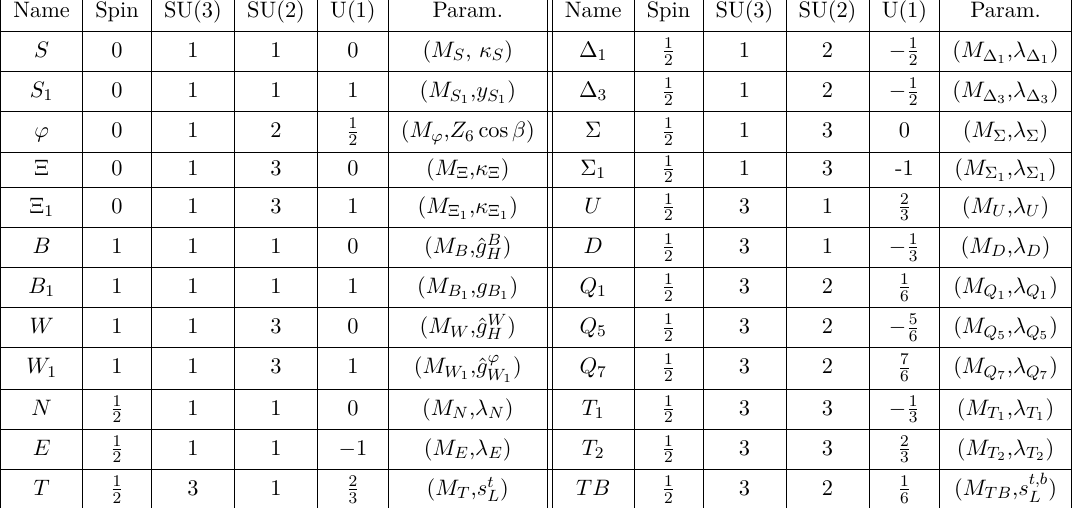
Table 3 . Single-field extensions of the SM constrained by our